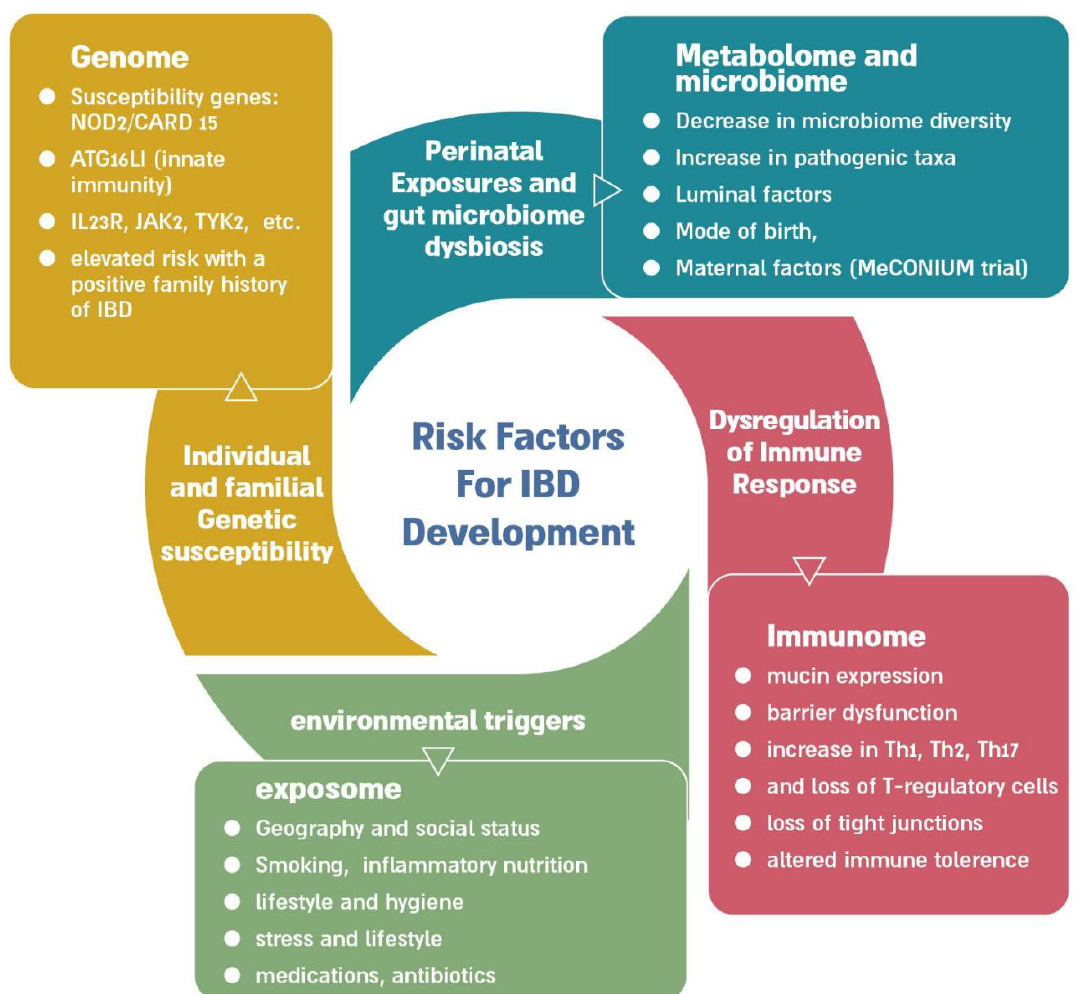
Figure 1. IBD is a multifactorial disease, arising from a complicated interplay between many factors, including genetics, epigenetics, disorders in the immune system, the microbiome, external environ- mental triggers, and more. All these variables can serve as future potential biomarkers, aiding in diagnosis and prognostication.